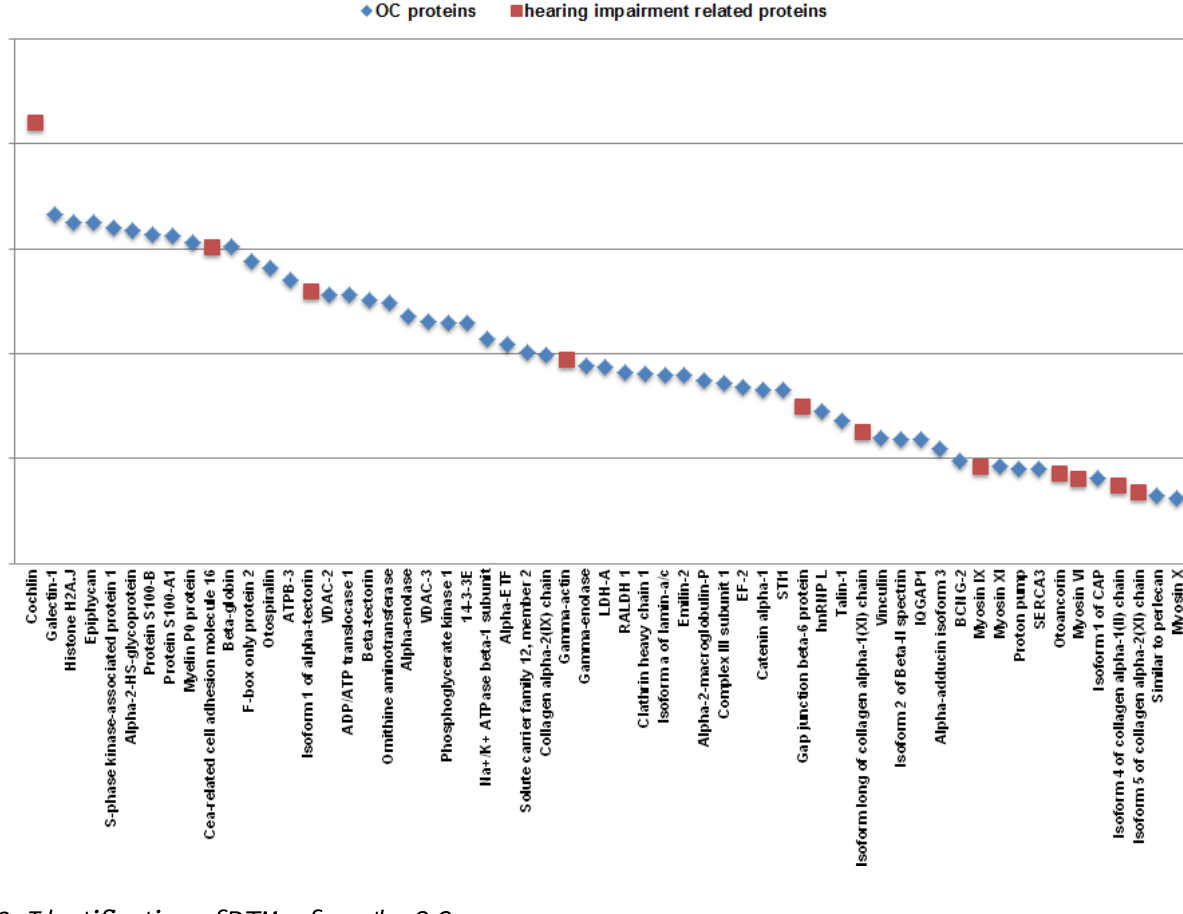
Figure 3. Dynamic range of 60 selected proteins from the mouse OC sample. All log10 values were based on normalized spectra abundance factor (NSAF) values which were used to normalize spectral count. Proteins identified in the OC and the hearing impairment related proteins were labeled as blue diamonds and red squares,